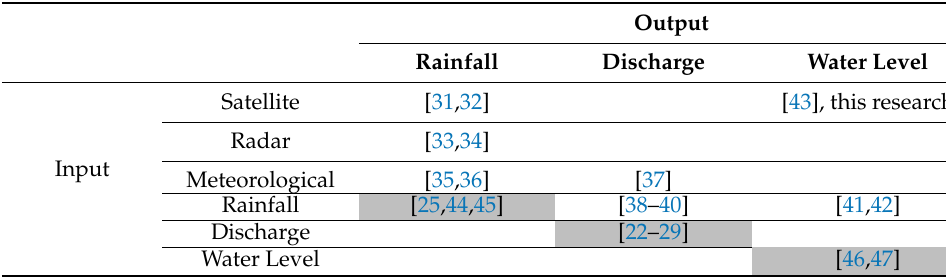
Table 1. Comparison between data source and target output variables in the resect publications in the field of machine learning-based flood prediction research. The shaded cells denote the same datatypes used for prediction source and